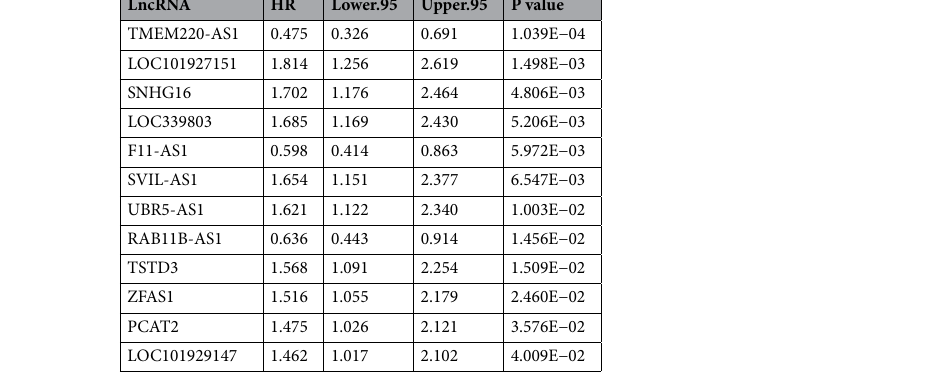
Table 3. Univariate Cox regression